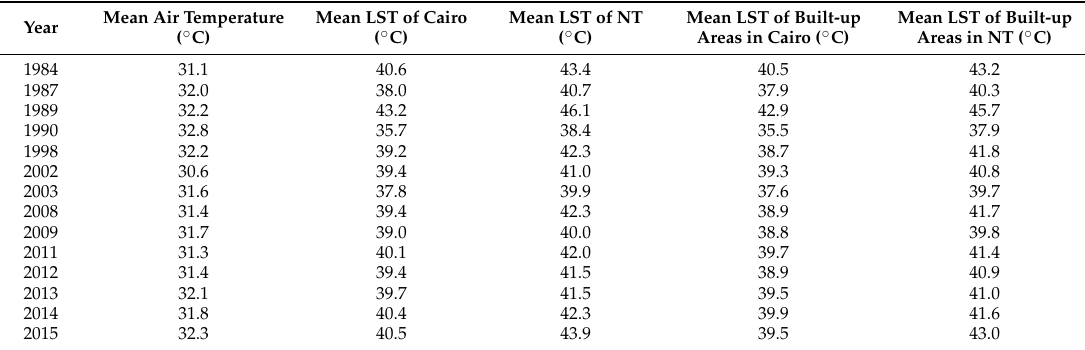
Table 6. The generated time series of air temperature without high deviation from mean air temperature and its corresponding mean LST time